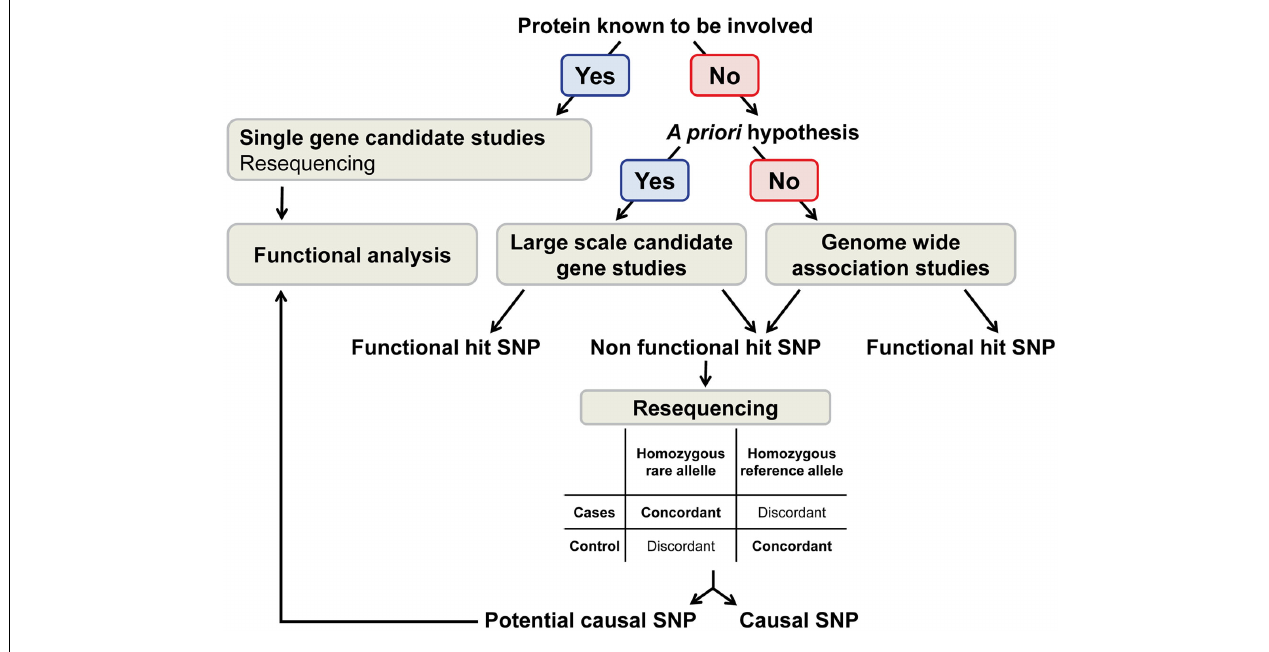
FIGURE 1 | Current pipeline used in